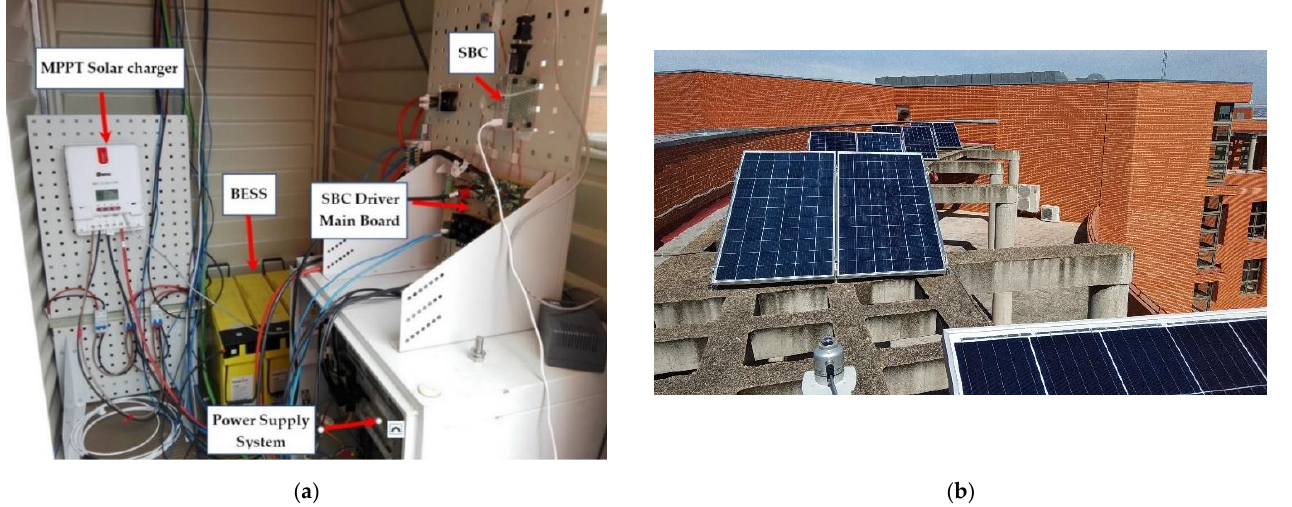
Figure 14. ( a ) Cabinet of the MG-based BTS and ( b ) PV installation including the meteorological station.